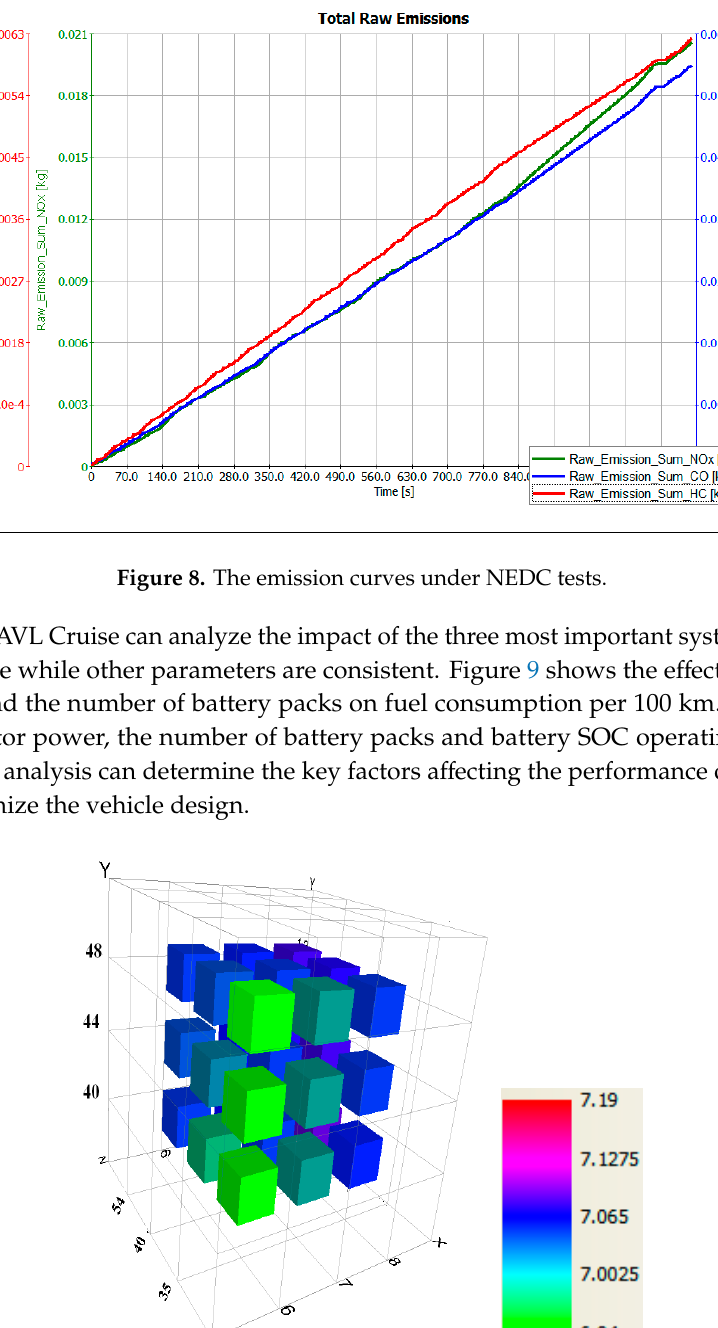
Figure 7. The fuel and power consumption curves under NEDC tests.